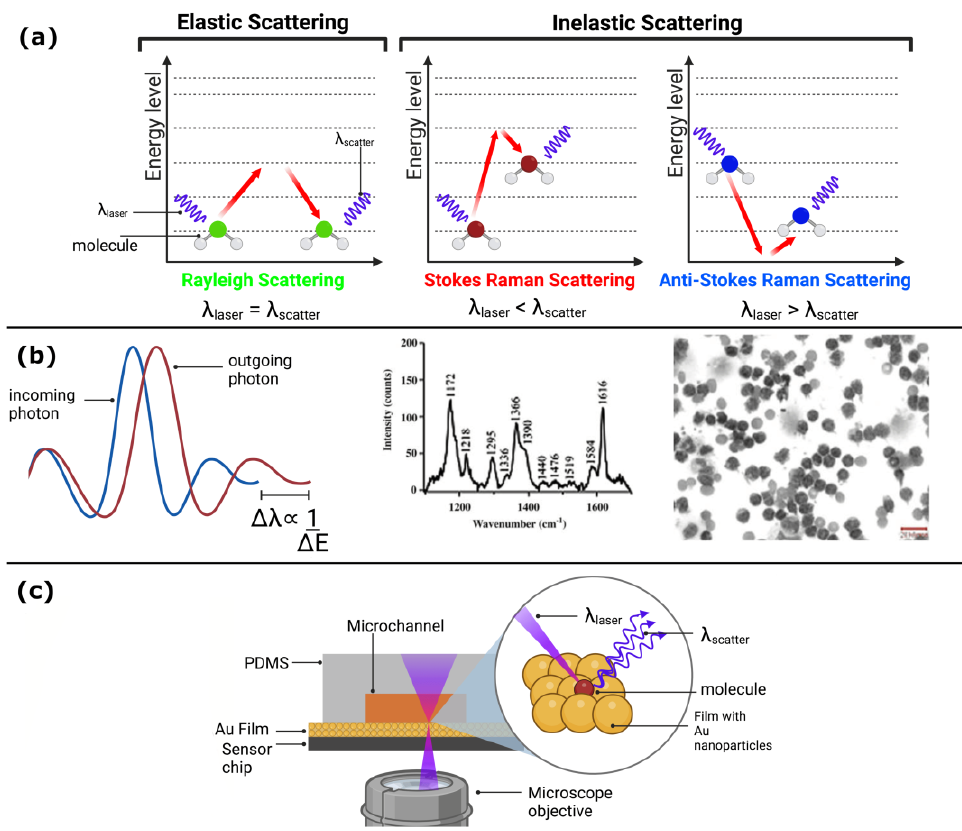
Figure 5. ( a ) Energetic levels in SERS: understanding the interaction between molecules and plas- monic nanoparticles. ( b ) Bright field accompanying with Raman spectra of chronic lymphocytic leukemia cells stained with Giemsa and labeled with anti-CD19-SERS nanoparticles. Reproduced with the permission of [99]. ( c ) Integrated microfluidic and biosensing SERS system for high sensitivity detection in biomedical applications. (Created with Biorender.com).